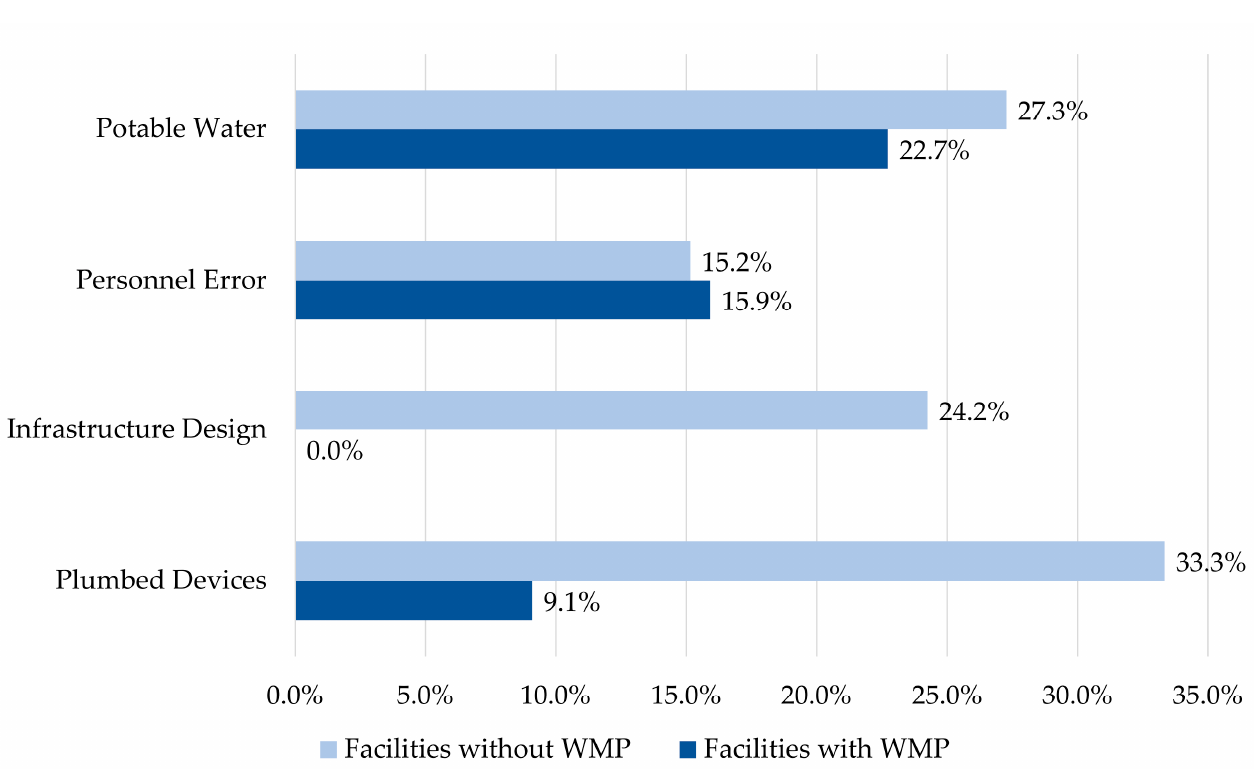
Figure 3. Prevalence of environmental deficiencies’ sources by water management status ( n = 77).